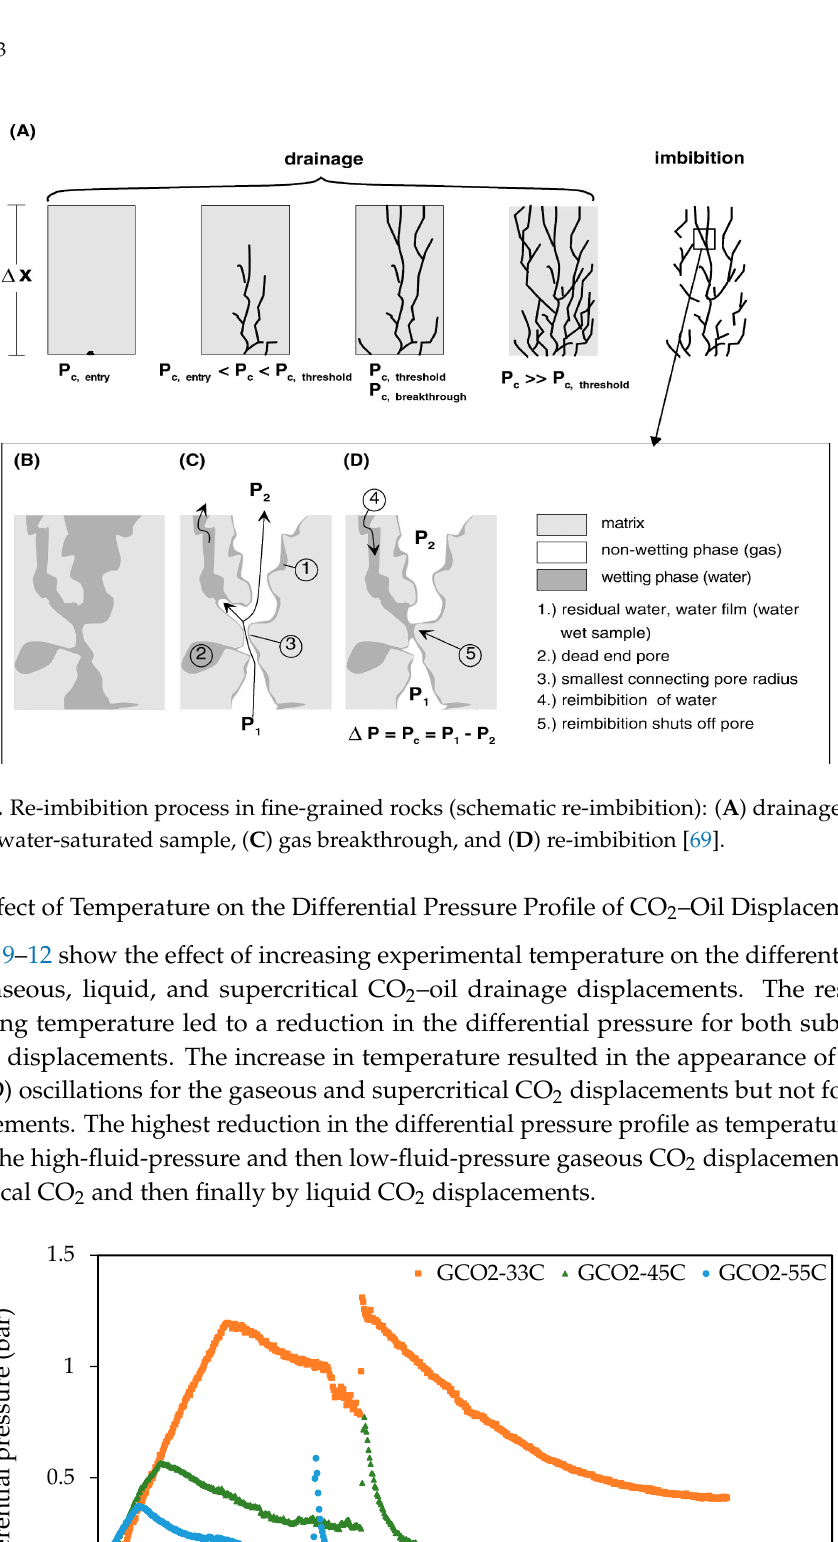
Figure 7. Interfacial tension (IFT) tension for CO 2 -crude oils (WO = Weyburn crude oil-CO 2 system against equilibrium pressure data at T = 27 °C [78]; A-0 and B-0 = Iranian crude oils at 49.85 °C [79]; BGA-13 = Iranian crude oil at 48.85 °C [80].